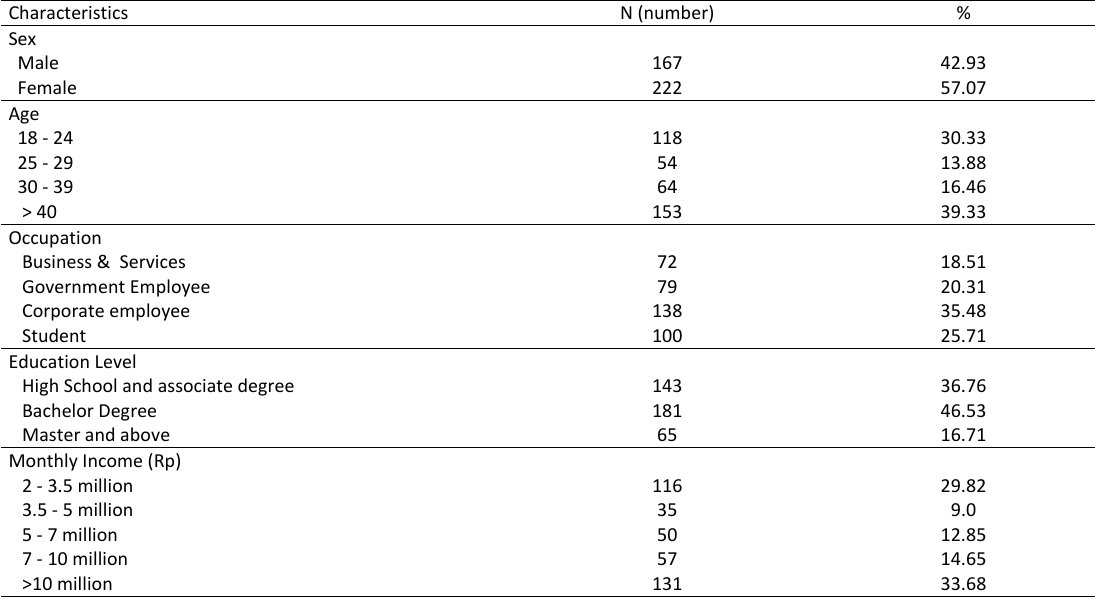
Table 1: Sociodemographic build of the resident